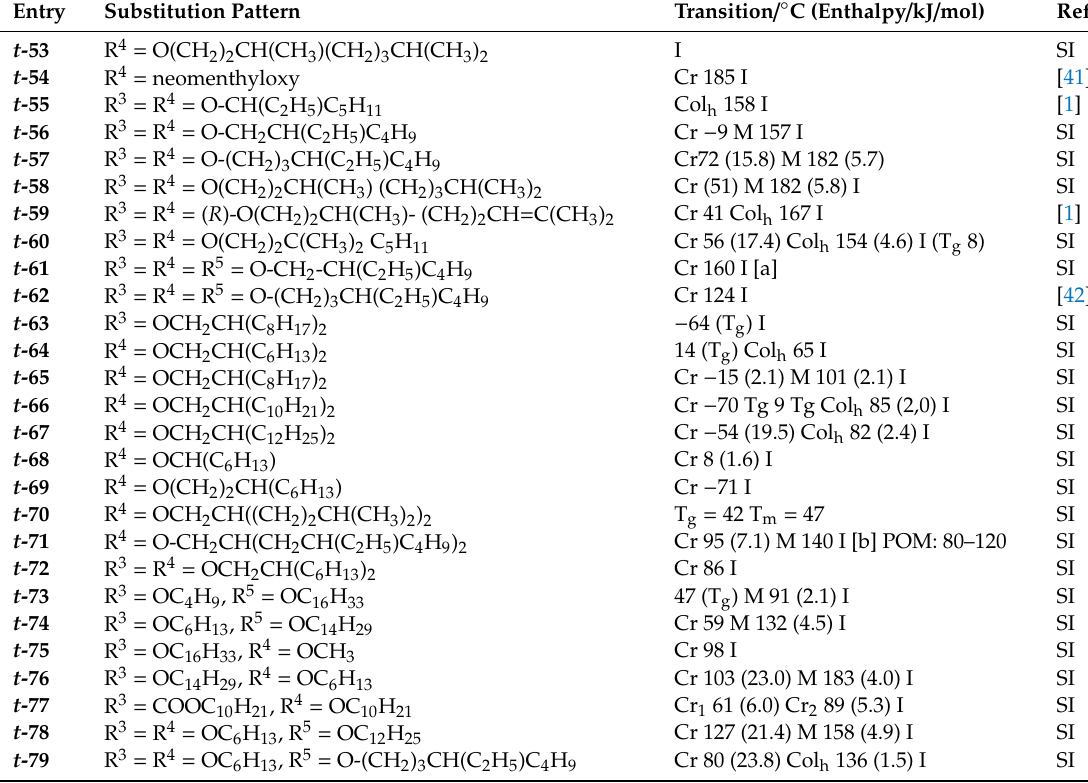
Table 3. t -TTTs with branched chains, swallow-tails and mixed-chain lengths, and data from thermal analysis.